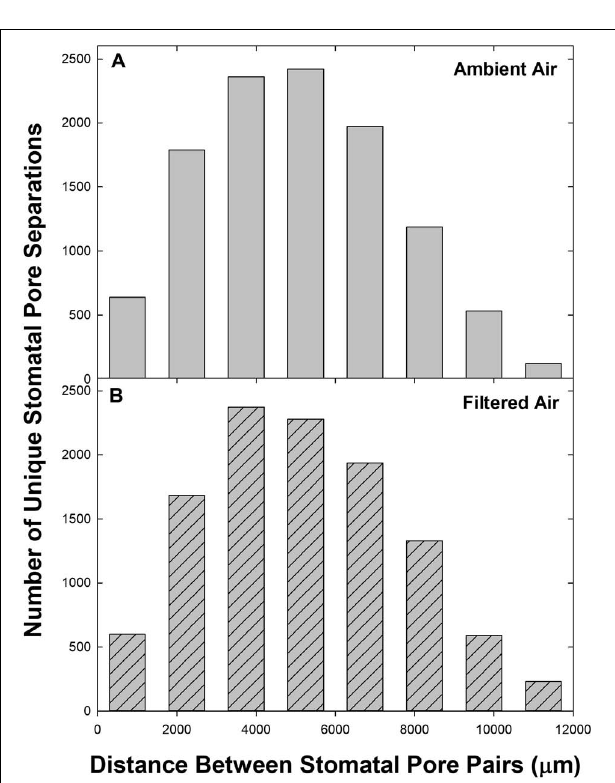
FIGURE 2 | Frequency distribution of pore separations (d) among the 50 stomata measured on each of 9 leaves ( n = 11,025 per panel). Distance classes: 0 ≤ d < 1500 to 10500 ≤ d < 12000, centered at 750–11250. For d ≥ 12000 ( n = 20 for AA and 55 for FA) frequencies were pooled with 10500 ≤ d < 12000. (A) Ambient air; (B) filtered